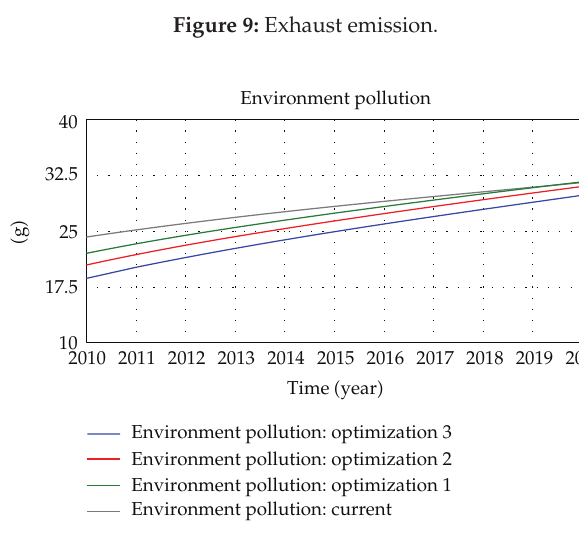
Exhaust emission: optimization 3 Exhaust emission: optimization 2 Exhaust emission: optimization 1 Exhaust emission: Figure 9: Exhaust emission.